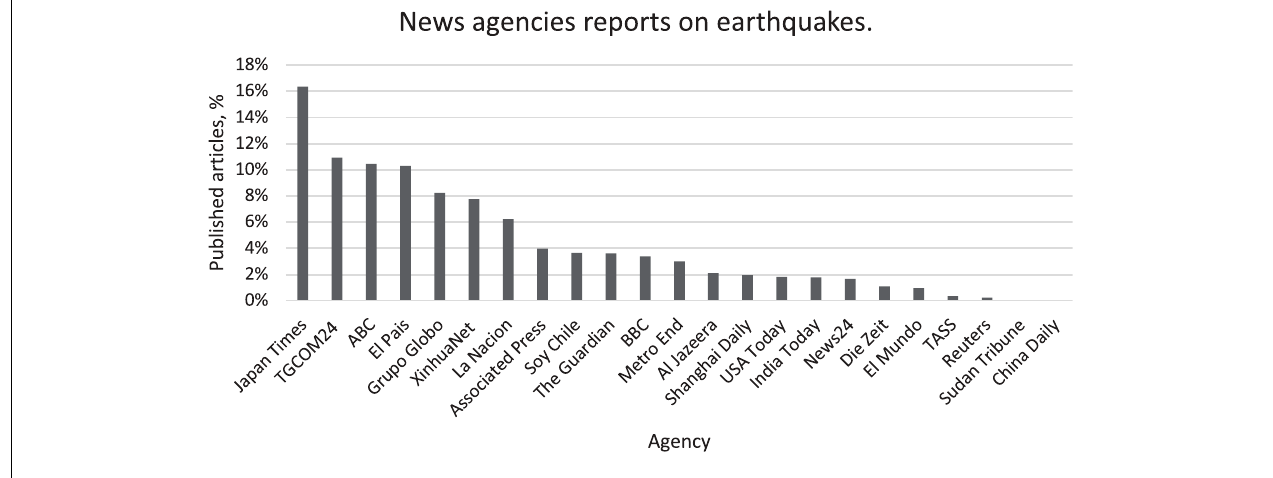
FIGURE 1 | Comparison of published earthquake-related articles per news